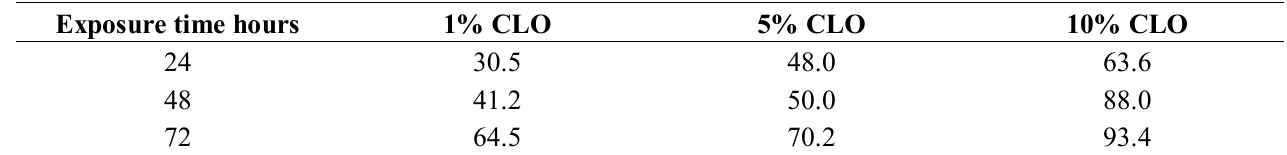
Table 1. Sporicidal activity of CLO; % kill (cfu).